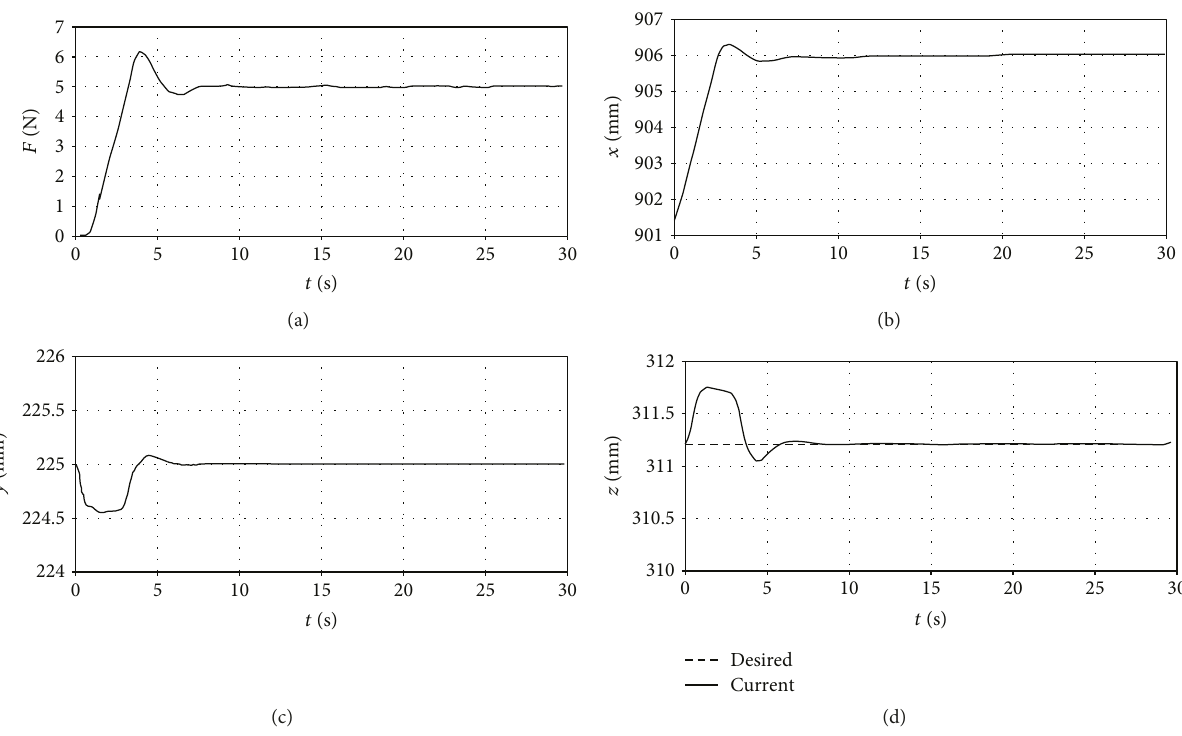
Figure 18: Force and position response curve under impedance control: (a) force applied in x direction, (b) position response in x direction, (c) position response in y direction, and (d) position response in z